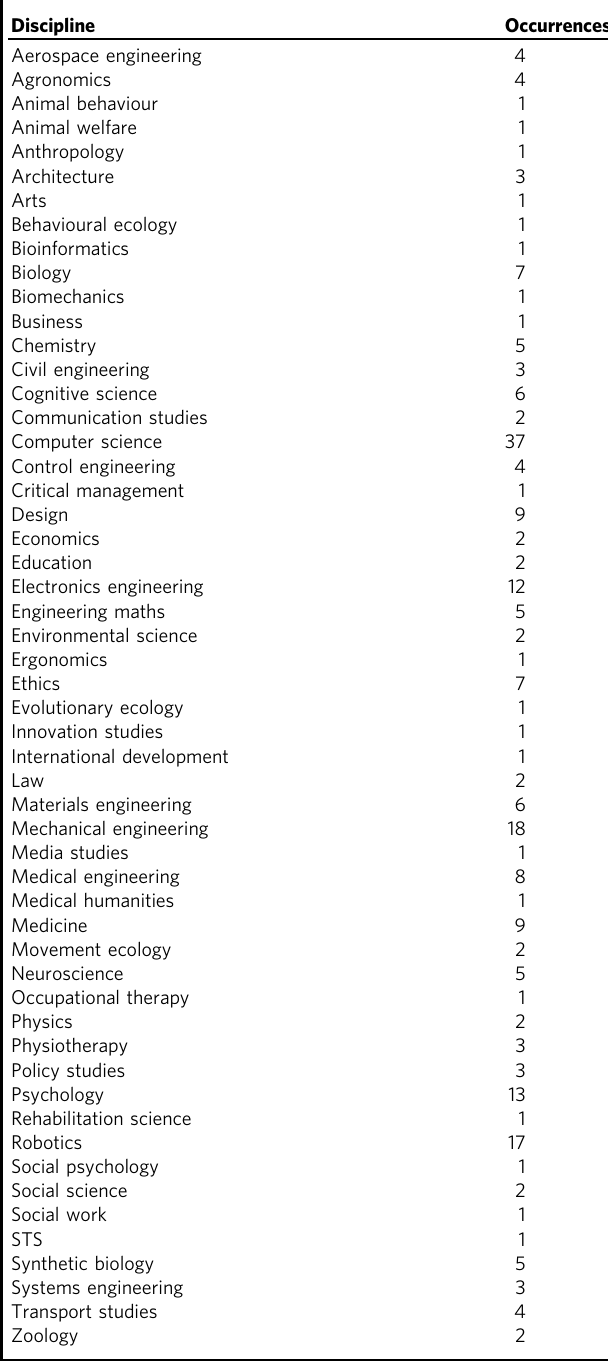
Table 3 Disciplines present across the recent 63 BRL